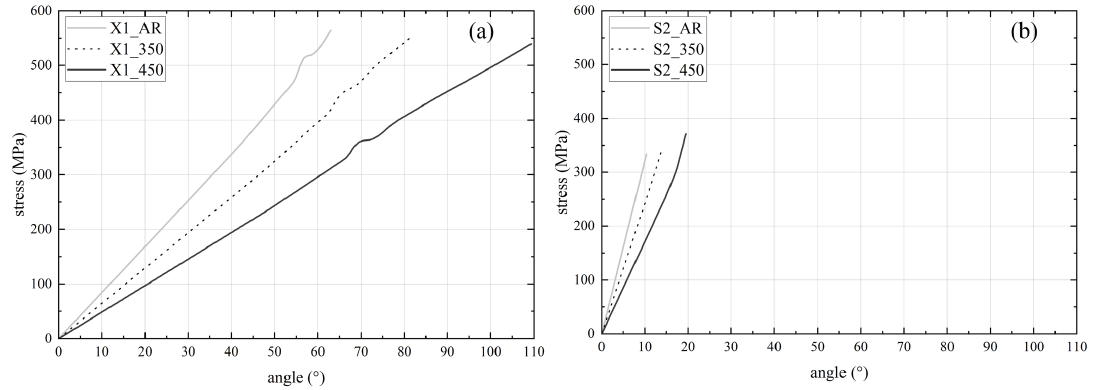
Figure 10. Mean stress curves under torsion up to 0.10 Ncm: (a) X1 file and their respective heat treatment conditions and (b) S2 file and their respective heat treatment